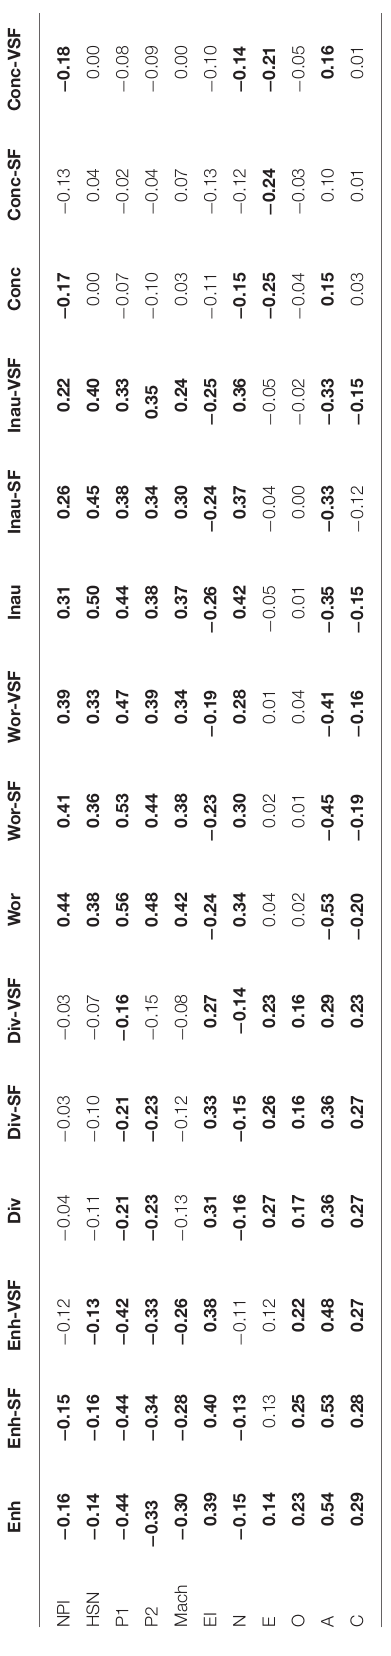
TABLE 7 | Internal reliabilities (omega coefficients) for Sample 1.